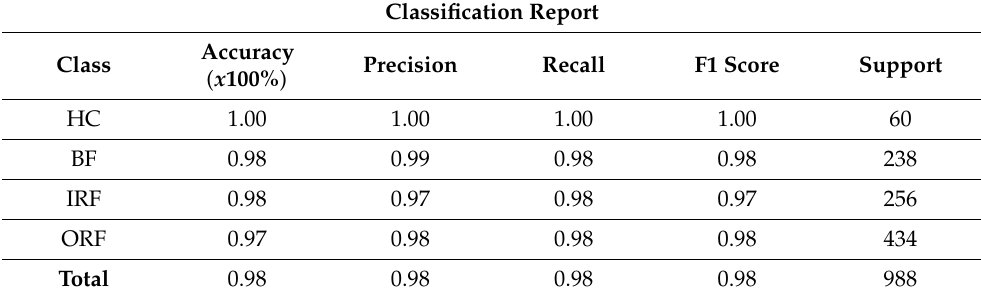
Table 3. Classification report of the testing dataset.